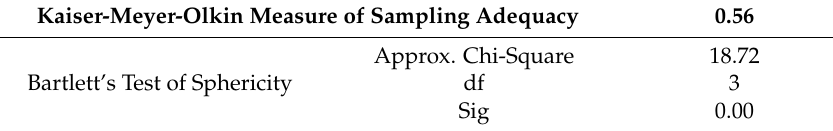
Table 6. Kaiser-Meyer-Olkin and Bartlett test results.